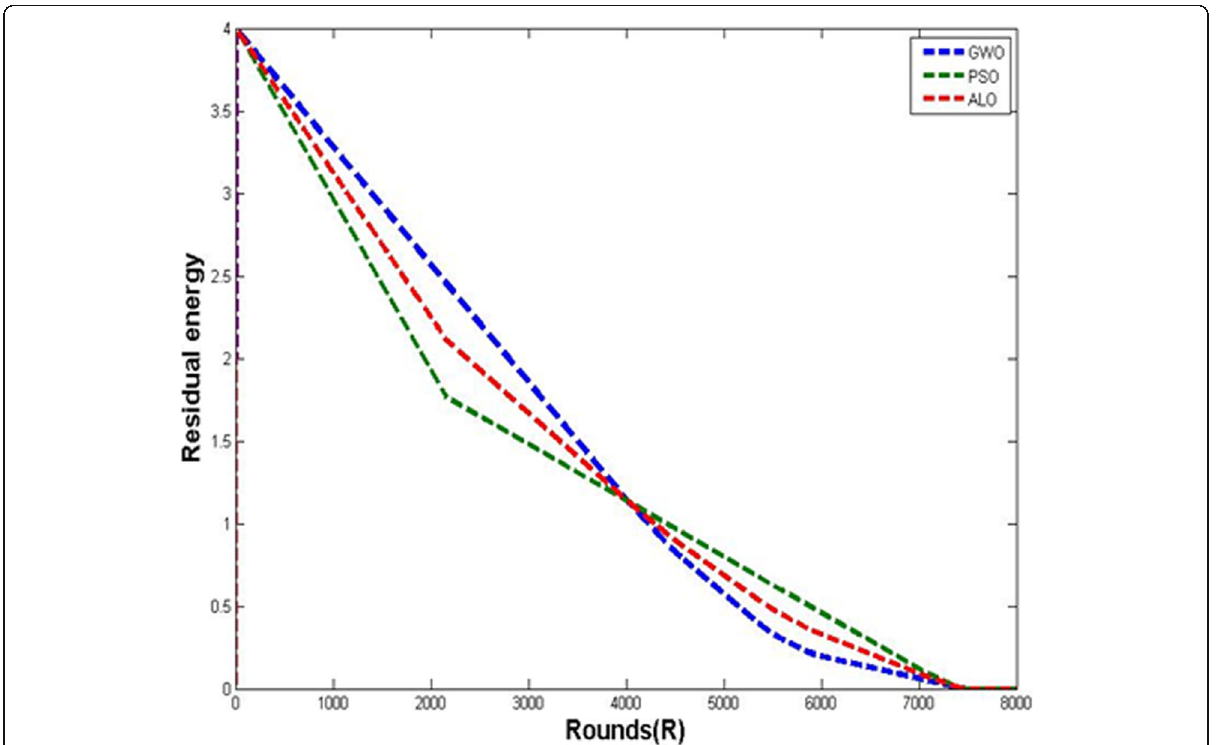
Fig. 5 Residual energy for PSO, ALO, and GWO for